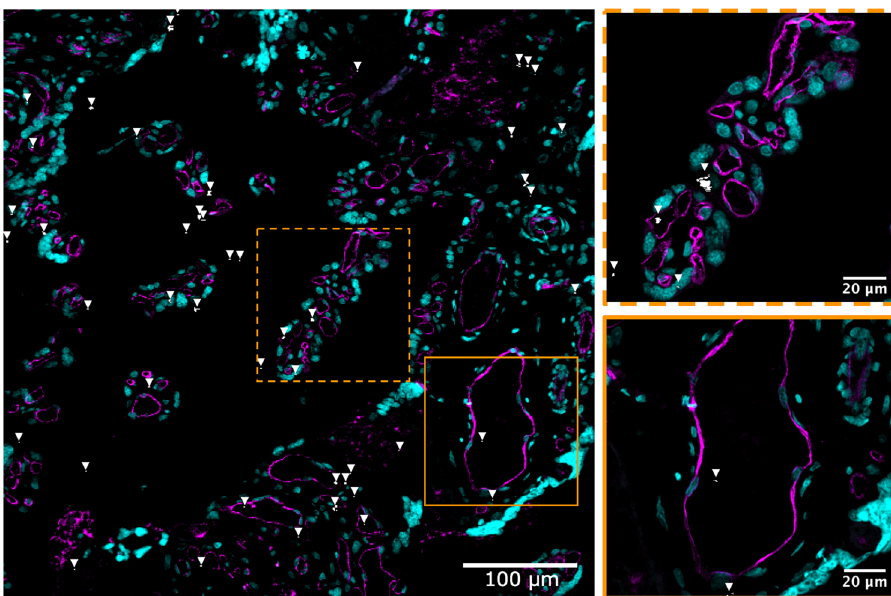
Fig. 2 Confocal images of placental tissue sections indicating the presence of carbon particles inside fetal microvessels. Fetal capillaries were visualized using anti-CD31 antibodies directed against endothelial cells (magenta), and Syto 61 Red fl uorescent nucleic acid stain (cyan) was used as a counterstain. The carbon particles (white and further indicated using white arrowheads) were imaged under femtosecond pulsed laser illumination (excitation 810 nm). Stainings were performed in triplicate and presented images are representative for samples collected from two